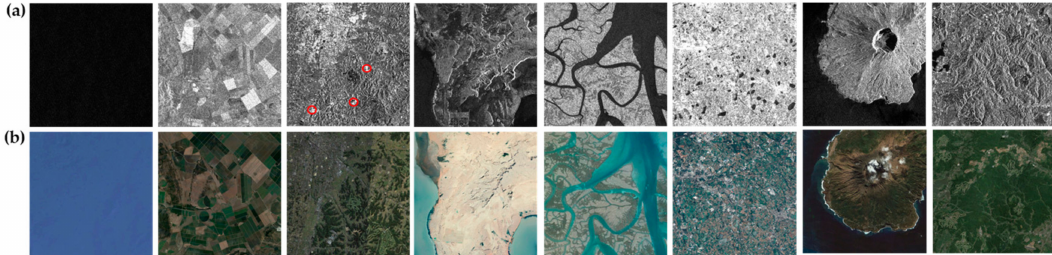
Figure 13. Abundant pure backgrounds of SAR images in LS-SSDD-v1.0. ( a ) SAR images; ( b ) optical images. Sea surface; farmlands; urban areas; Gobi; remote rivers; villages; volcanos;